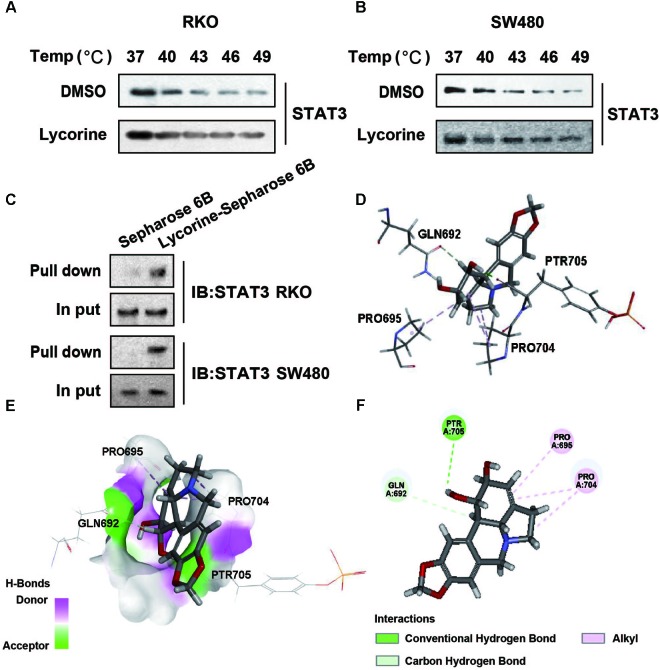
Lycorine targets STAT3 in CRC Cells. (A,B) cells were treated with 40 μM of lycorine for 24 h and subsequently heated at different temperature for 3 min. after freeze-thaw cycles for cell lysis, the soluble STAT3 protein levels bound to a drug were visualized by Western blot assays. (C) Pull-down assay showing an interaction between lycorine and STAT3. Lycorine was conjugated with epoxy-activated Sepharose 6B. (D–F) Docking model of lycorine with STAT3. (D) The interaction pattern of lycorine with the residues. (E) Lycorine binding with the pocket is composed of hydrogen bonds. (F) 2D diagram between the receptor and ligand. All the western data shown are representative of at least three independent experiments.